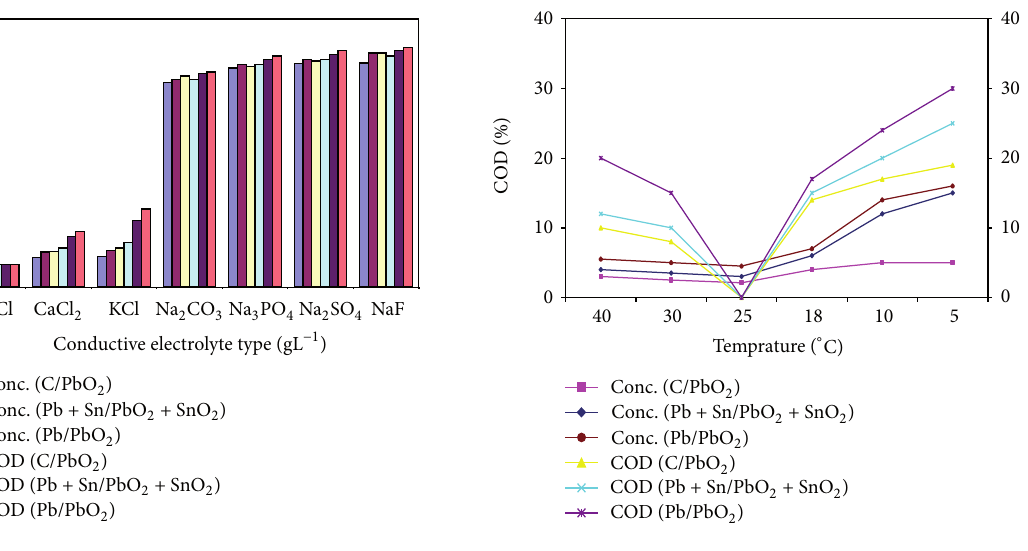
F 5: e effect of temperature on RY160 and COD removal using C/PbO 2